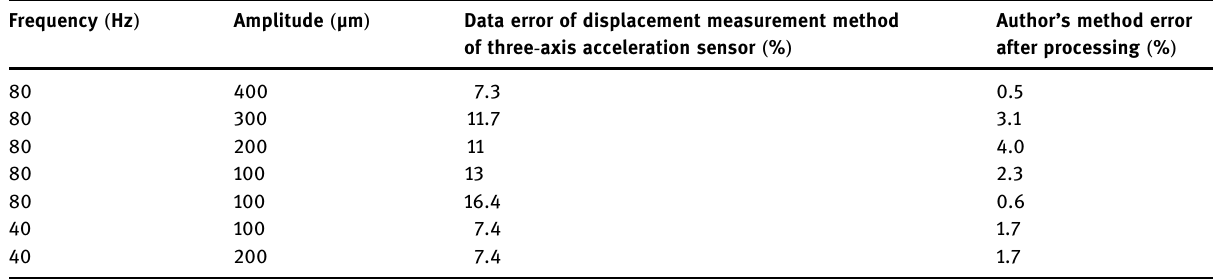
Table 1: Error analysis and comparison of the results calculated by the proposed method and the displacement measurement method of the three - axis acceleration sensor Frequency ( Hz